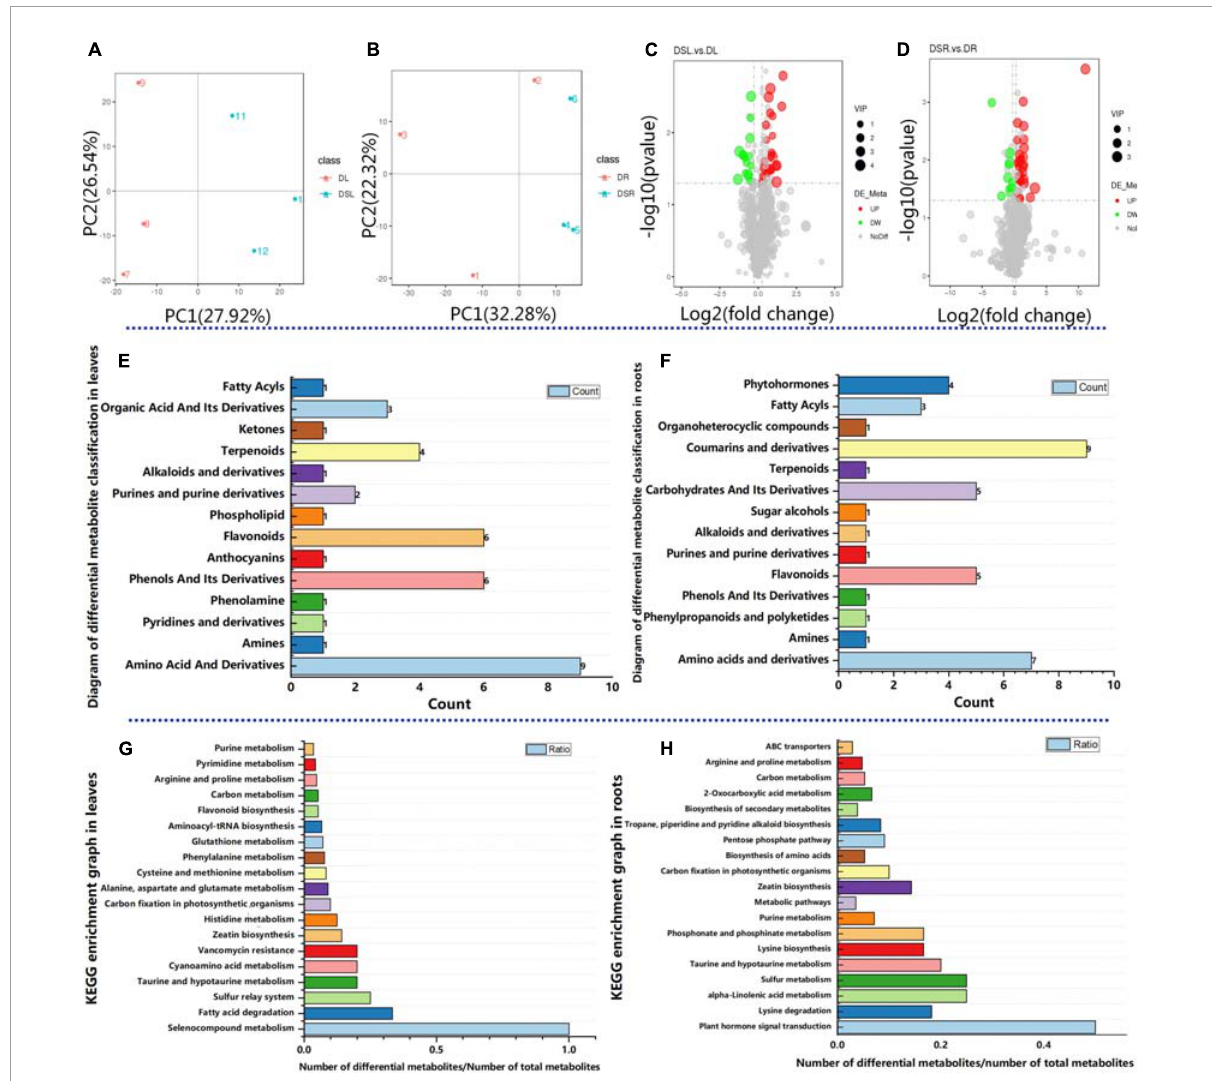
FIGURE3 Effect of Si on quasi-targeted metabolomics in rice under dry cultivation. Principal component analysis (PCA) of metabolites in leaves (A) and roots (B) . The X -axis represents the first principal component (PC1), and the Y -axis represents the second principal component (PC2). Volcano plots for differentially accumulated metabolites (DAMs) from the leaves with and without Si treatment (C) and the roots with and without Si treatment (D) . Diagram of differential metabolite classification, with the horizontal coordinate showing the number of differential metabolites in the corresponding metabolic pathway and the vertical coordinate showing the corresponding metabolome classification in leaves (E) and roots (F) . Top KEGG enrichment results. The horizontal coordinate shows the number of differential metabolites in the corresponding metabolic pathway/the number of total metabolites identified in the pathway; the larger the value, the higher the enrichment of differential metabolites in the pathway in leaves (G) and roots (H)